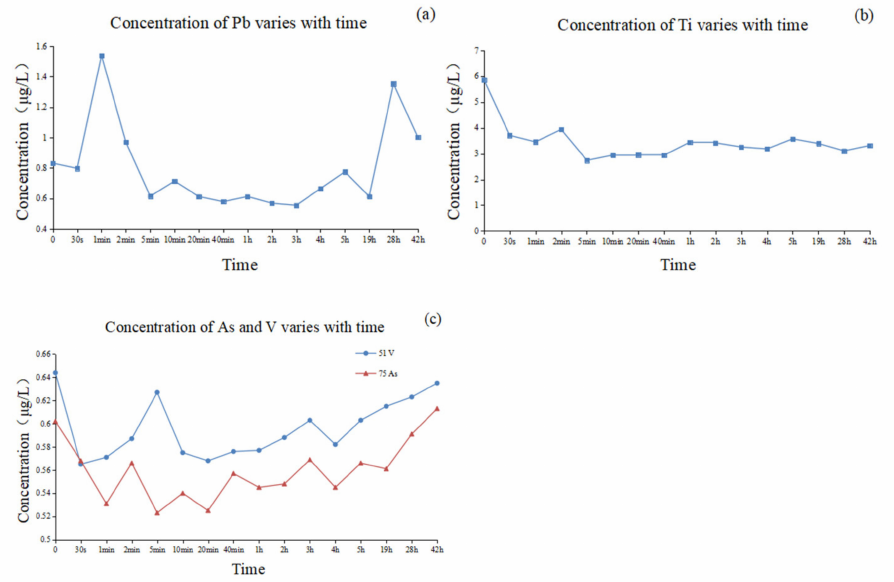
Figure 8. In UF water the effects of suspended particulate matter at different time adsorption and release of Pd ( a ); Ti ( b ) and V ( c